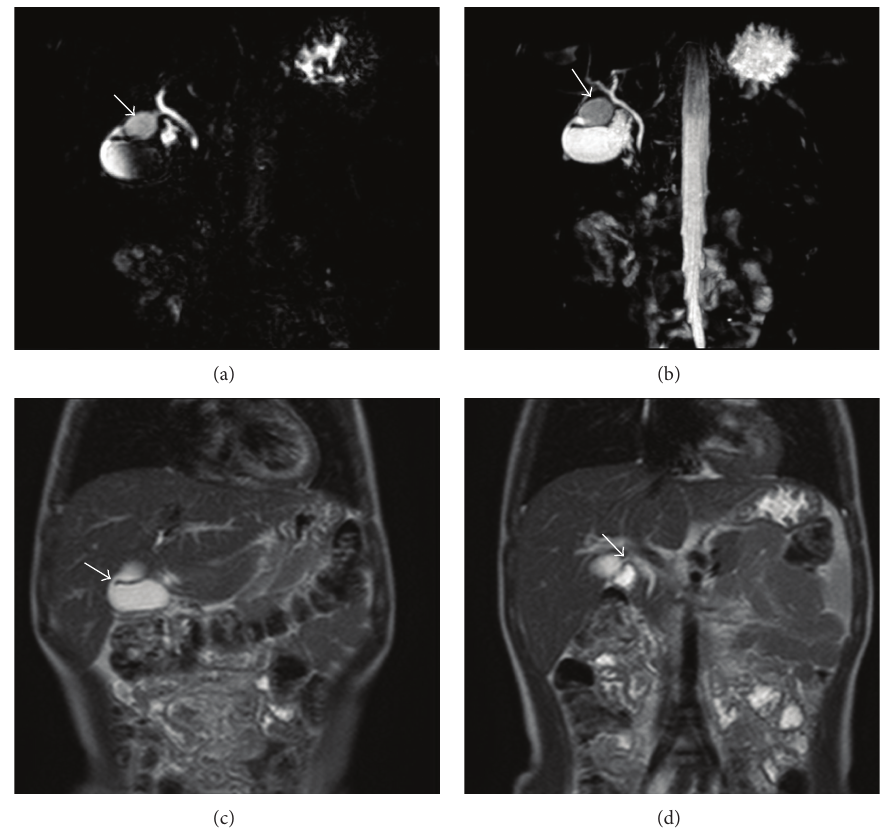
Figure 2: Cystic dilatation of the cystic duct was determined in coronal MRCP and T2-weighted MR images. ((a), (b)) Cystic dilatation is observed in the cystic duct in MRCP images (arrow). The intrahepatic bile ducts and the choledochus are normal. The connection of the dilated cystic duct segment with both gall bladder (c) and choledochus (d) could be determined (arrows). and the intravenous contrast agent, especially in children